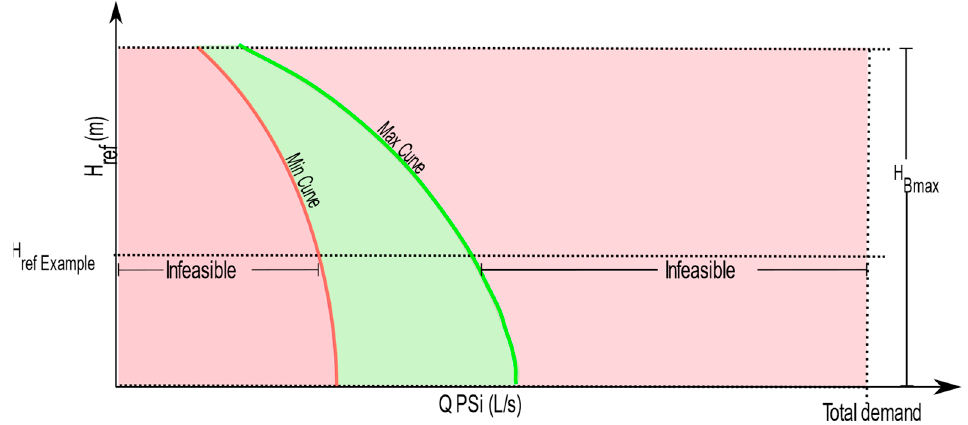
Figure 1. Infeasibility map for PS i.